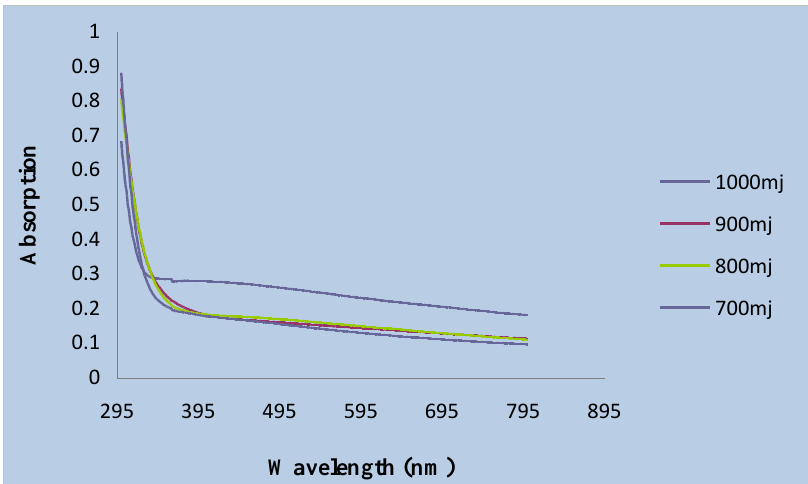
Fig.3: Optical Absorption as a function of wavelength for ZnS/glass at different laser energy.